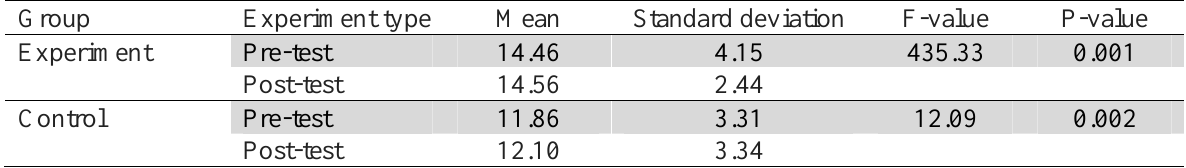
The results of testing FLE on friends and families